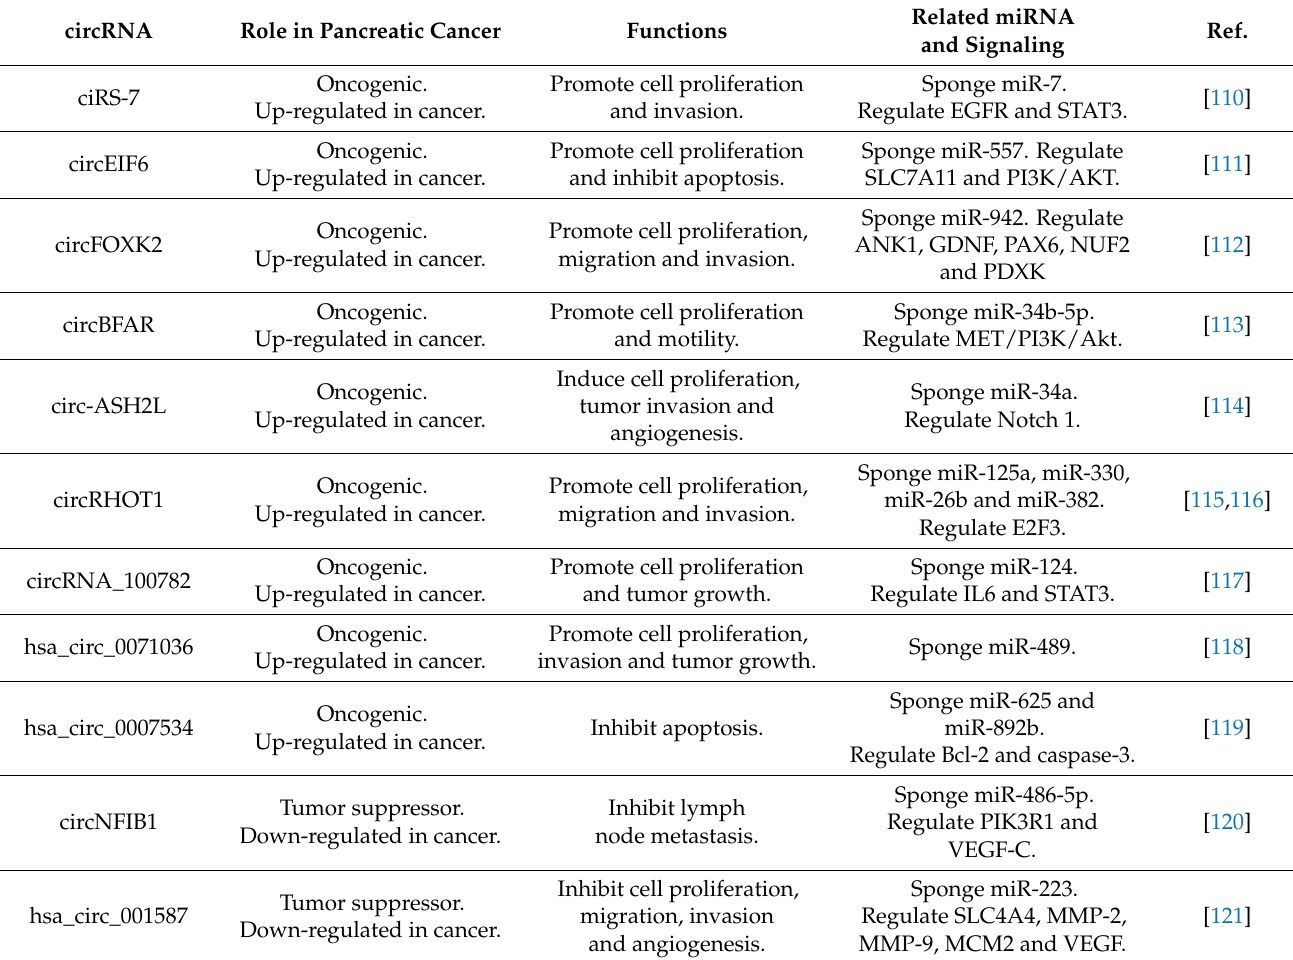
Table 2. Major circRNAs in pancreatic